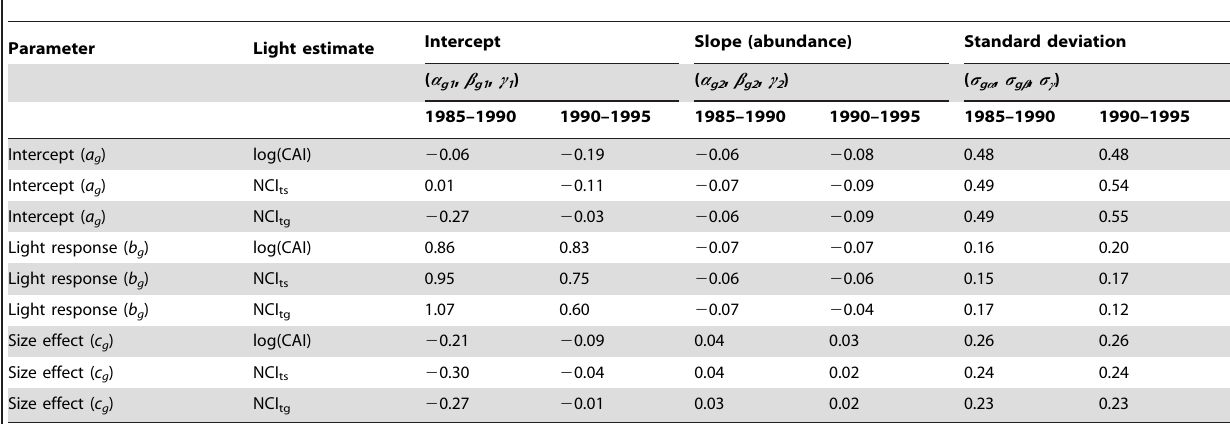
Table 4. Posterior estimates of hyperparameters for the species-specific parameters of the growth model.